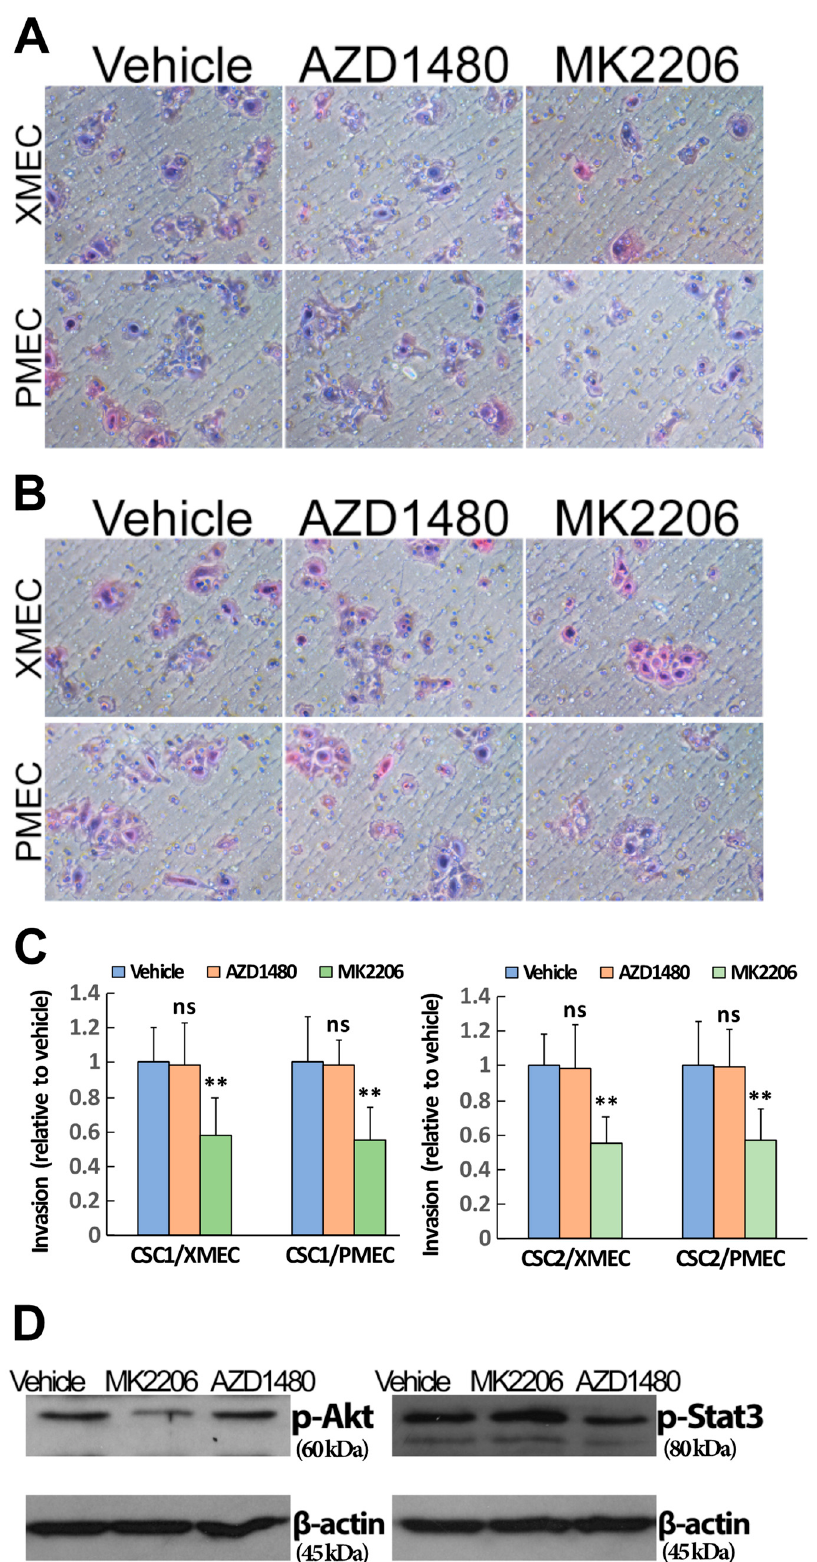
Figure 5. PI3K/Akt signaling pathway contributed to the effects of tumor stromal cells on CSC invasiveness. ( A ) The blockade of PI3K/Akt signaling reduced the enhancement of CSC cell invasion induced by either patient-derived xenograft tumor stromal cells (top panel) or patient primary tumor stromal cells (bottom panel). The blockade of JAK/STAT3 signaling did not affect the cell